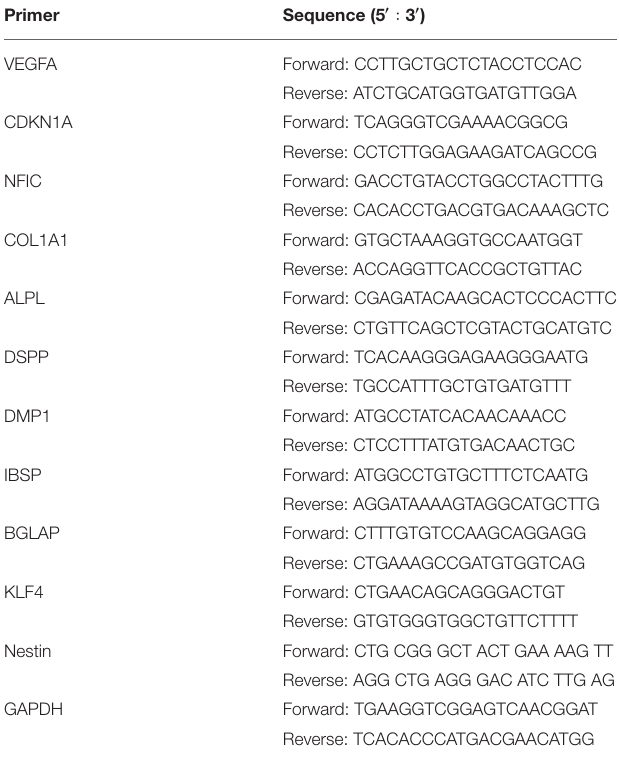
TABLE 1 | Polymerase chain reaction (PCR) primer sequences of target genes.